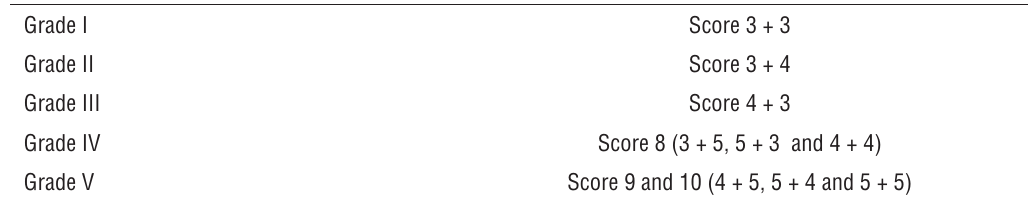
Table 1 - new recommendation of International society of urological pathology (Isup)